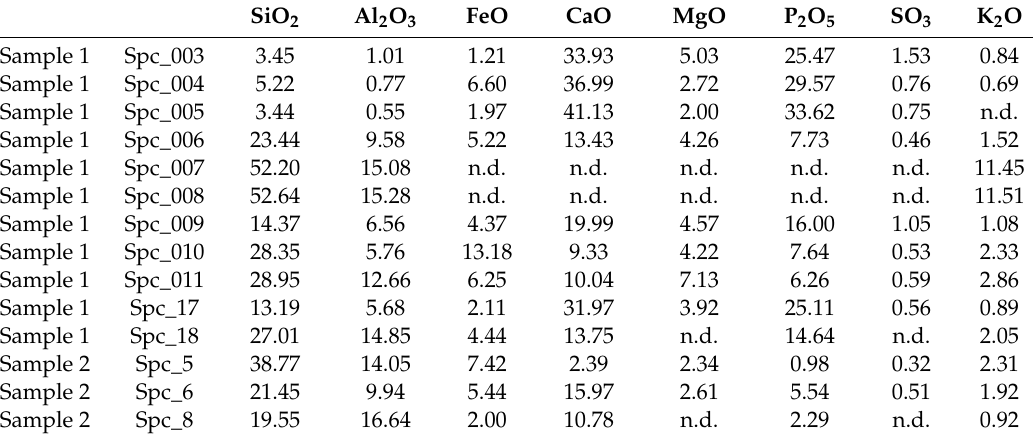
Table 1. EDS analyses of coatings from sample 1 and 2. All measurement data normalized to 100 weight % oxides, not all elements are shown. n.d. = not detected.